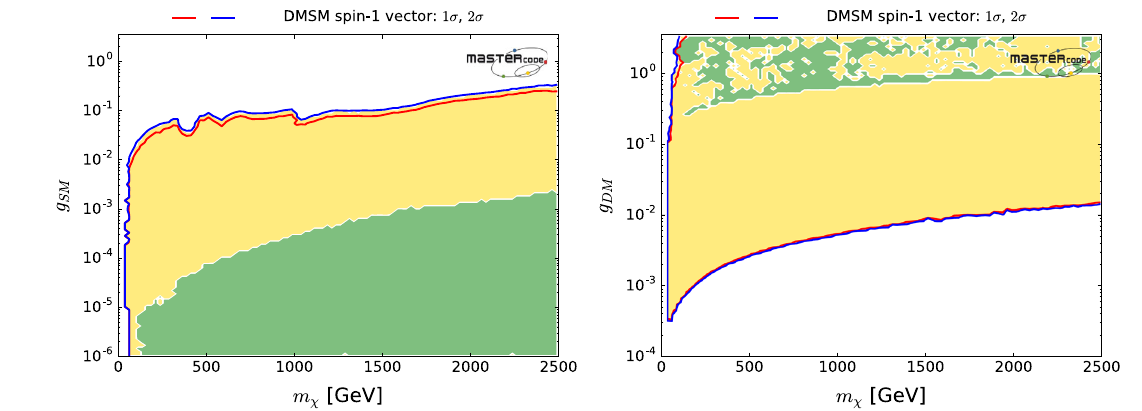
into pairs of mediator particles Y that subsequently decay into SM par- ticles, and yellow for rapid annihilation directly into SM particles via